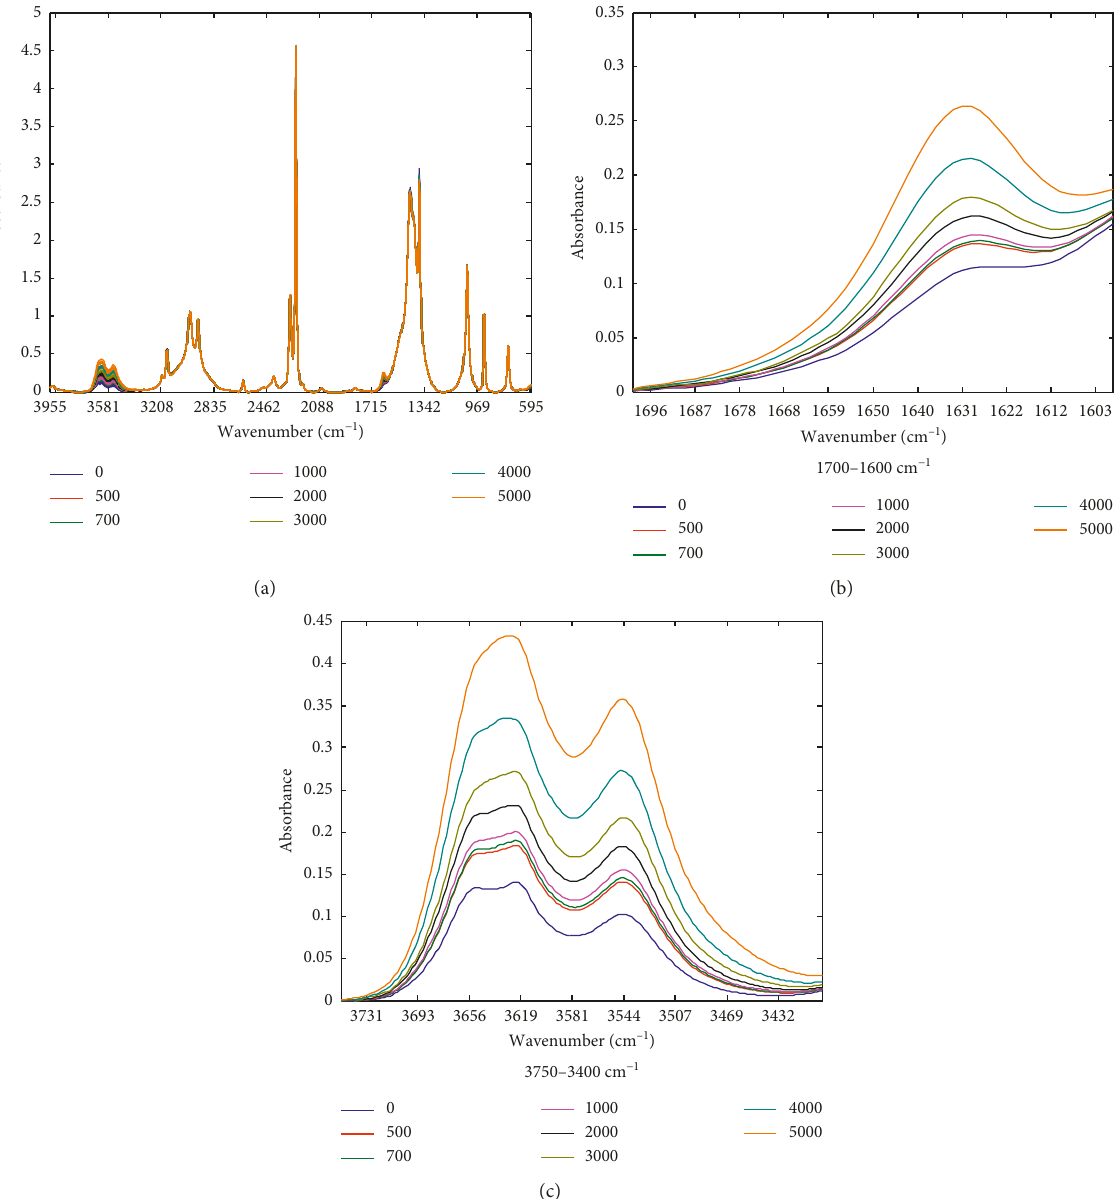
Figure 2: Spectra of acetonitrile with moisture extracted from lubricating